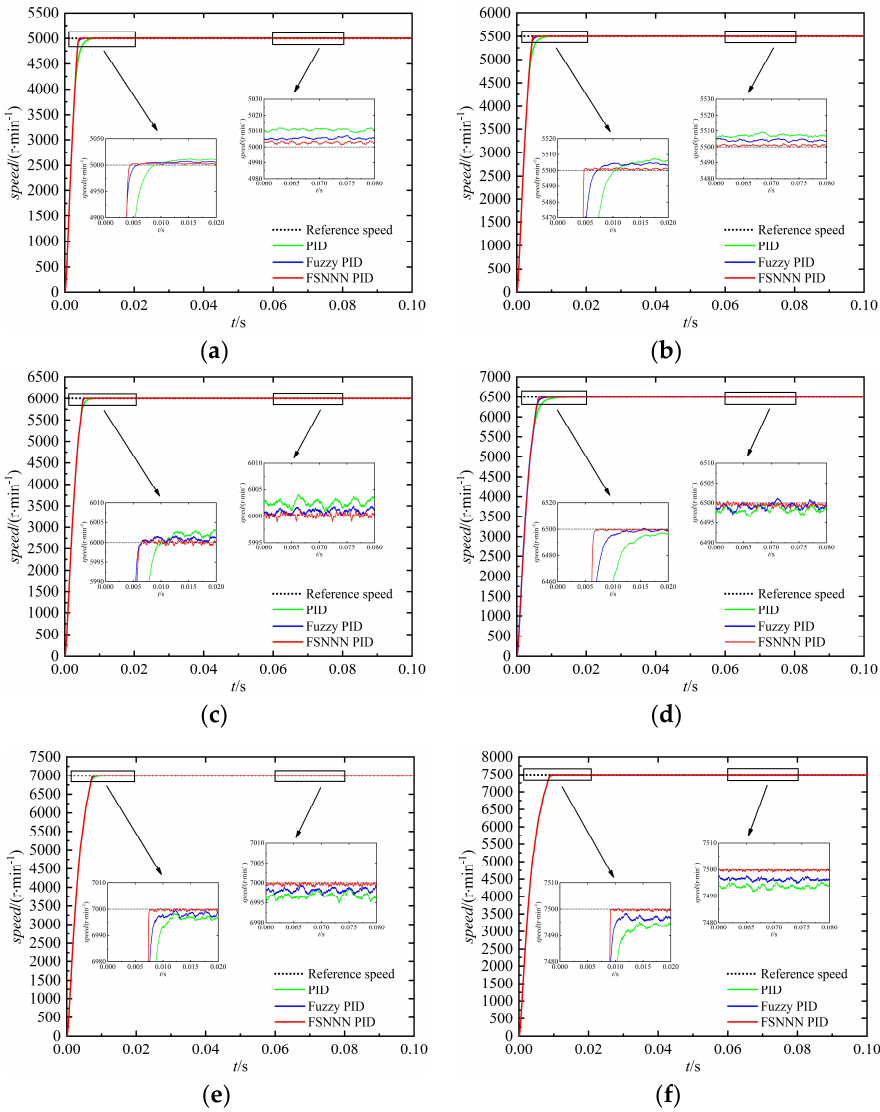
Figure 15. Speed step response of BLDCM at different reference speeds: ( a ) 5000 r/min; ( b ) 5500 r/min; ( c ) 6000 r/min; ( d ) 6500 r/min; ( e ) 7000 r/min; ( f ) 7500 r/min. Table 4. Motor speed step response of 7000 r/min under different algorithms.